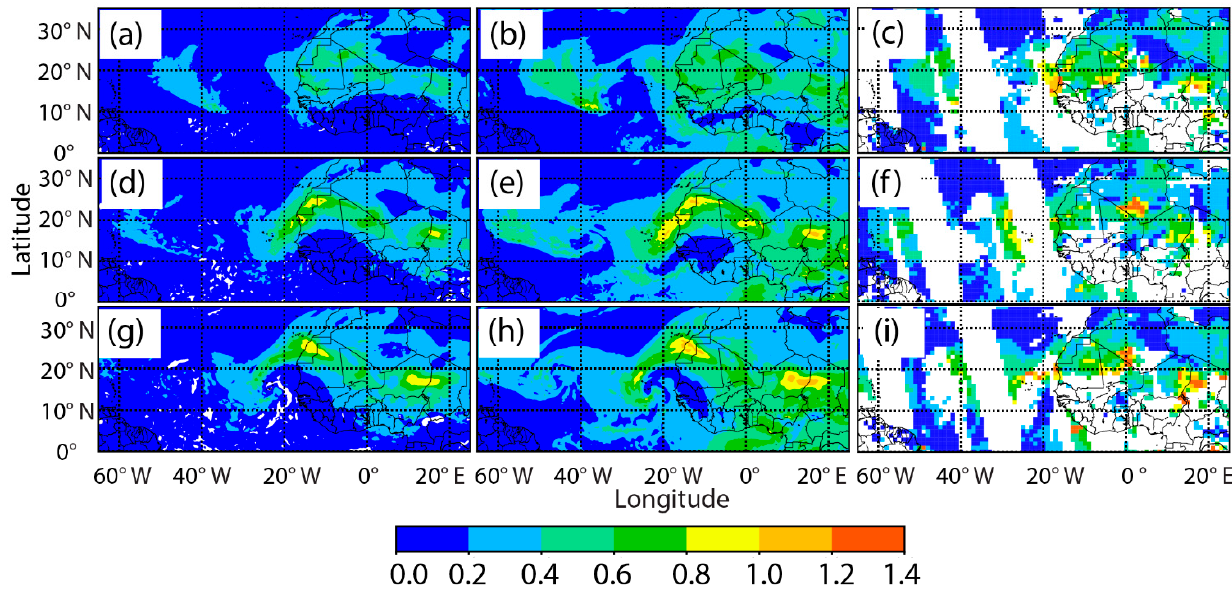
Figure 5. Difference of AOD at 550 nm (ExDO − ExO) at ( a ) 1400 UTC 22, ( d ) 1400 UTC 23, and ( g ) 1400 UTC 24 August 2010. AOD from experiment ExDO at ( b ) 1400 UTC 22, ( e ) 1400 UTC 23, and ( h ) 1400 UTC 24 August 2010. AOD from MODIS Aqua L3 daily product (combined dark target and deep blue) on ( c ) 22, ( f ) 23, and ( i ) 24 August 2010.